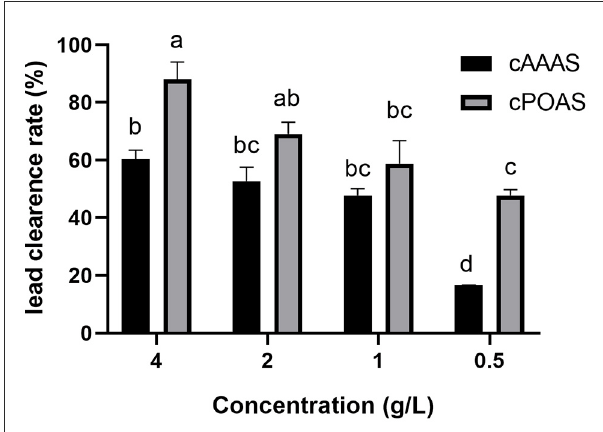
FIGURE1 Lead clearance rate of different concentrations of cAAAS and cPOAS. Different letters indicate a significant difference ( P < 0.05).